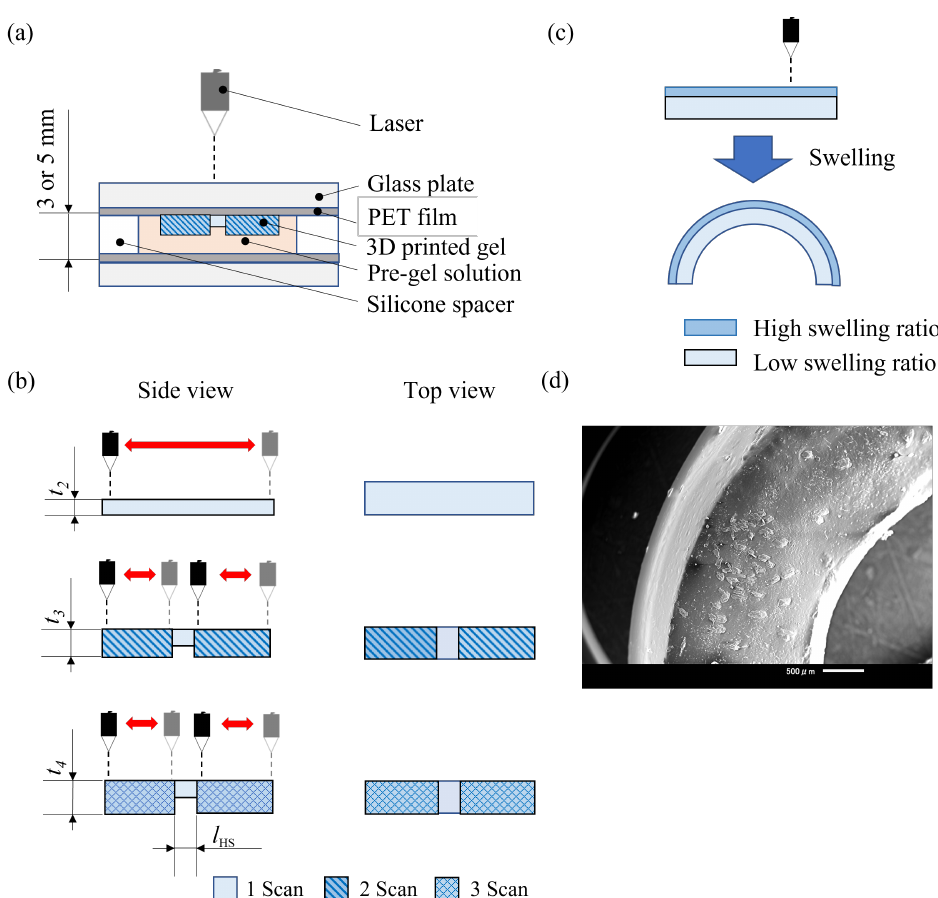
Figure 1. The process of 3D printing of the ICN gels with the hinge structure. ( a ) The side cross sectional view of the silicone mold placed on the platform of GelPiPer. Pre-gel solution is sandwiched with the picture-flame shape of 2 mm or 5 mm thickness silicone spacer (outer size: 8 cm × 8 cm, inner size: 7 cm × 7 cm) in the couple of 2 mm thickness glass plates, whose surfaces are covered with 0.5 mm thickness PET films. ( b ) The molding process of the 3D printed bilayer hydrogels with hinge structure. The scanning numbers can be increased in some areas, and the areas where the scanning numbers are increased will increase in thickness, and polymerization will progress. ( c ) Deformation of printed modeling objects. The upper figure shows deformation before being placed in water, and the lower figure shows it after being placed in water. Gels with different swelling on the top and bottom layers were printed. ( d ) The SEM image of the cross section of the dried ICN gels indicates the existence of the bilayer structure. The left side, which seems white, is the UV-exposed side. This part is the upper, thinner layer. The right side is the lower, thicker layer, where the particles of photoinitiator TPO crystals precipitated during the 3D printing process are